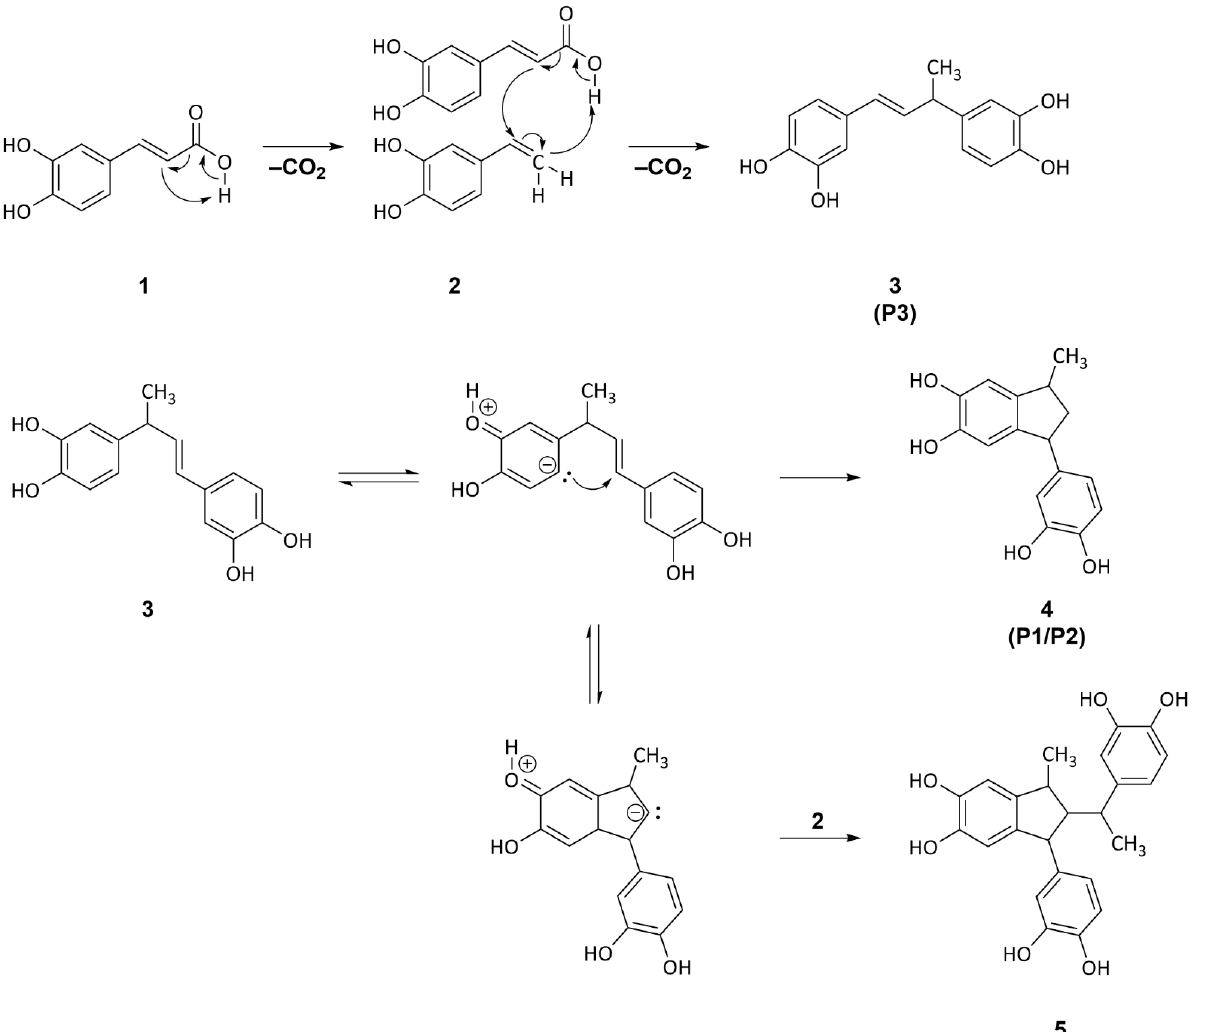
phenyl)-3-methyl-2,3dihydro-1 H -indene-5,6-diol 4 (P1, P2), whereas the addition of 2 before